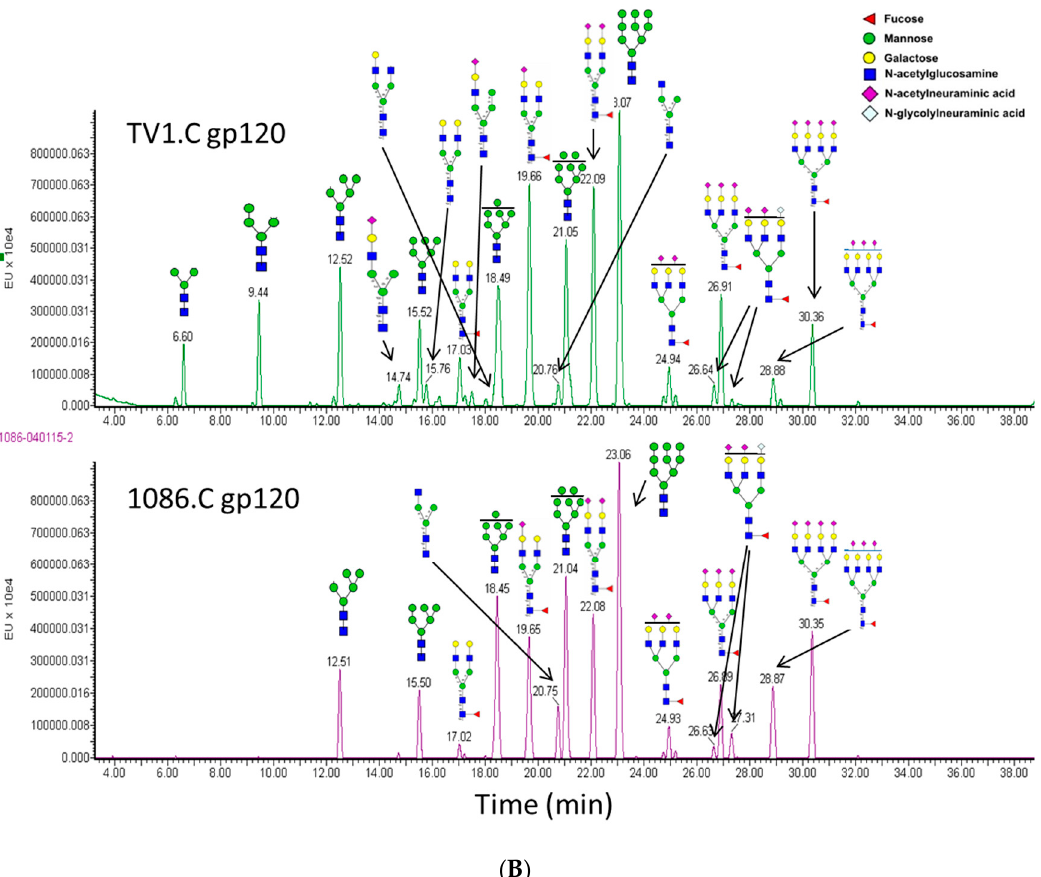
Figure 4. Characterization of N -linked glycosylation. ( A ) Sites and types of N -linked glycosylation in TV1.C (left panel) and 1086.C (right panel) gp120. Red: complex glycan; Blue: high mannose/hybrid glycan; Green: glycan type undetermined; Purple: Complex/high mannose/hybrid; Orange: non-glycosylated; Solid underscore: complete glycosylation; Dotted underscore: incomplete glycosylation; Brown box: modified by a single HexNAc. ( B ) N -linked glycosylation profiling of gp120s. Top panel, TV1.C gp120; lower panel, 1086.C gp120.